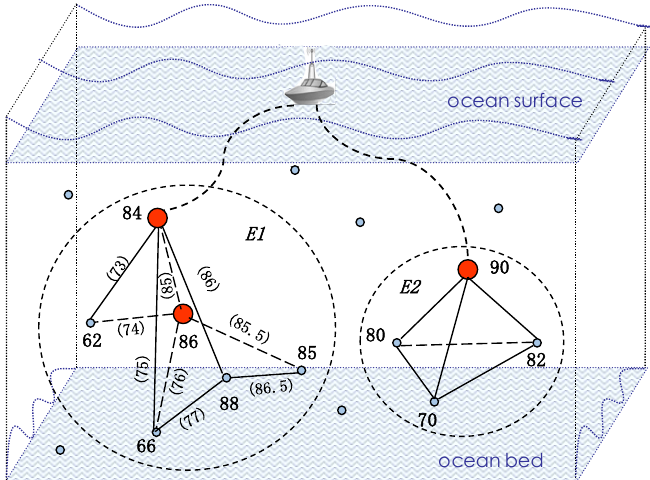
Figure 1. An example of event coverage and event sources. Specifically, the sensor node with the mark of 86 is the relay node for the sensor nodes with marks of 66, 88 and 85, and the sensor node with the mark of 84 is the relay node for the sensor nodes with marks of 62, 86 and itself. There are two events ( i.e ., E1 and E2 ), corresponding to two connected components in this graph, and event sources are the sensor nodes with marks of 84 and 86 for E1 and with the mark 90 for E2 , respectively.